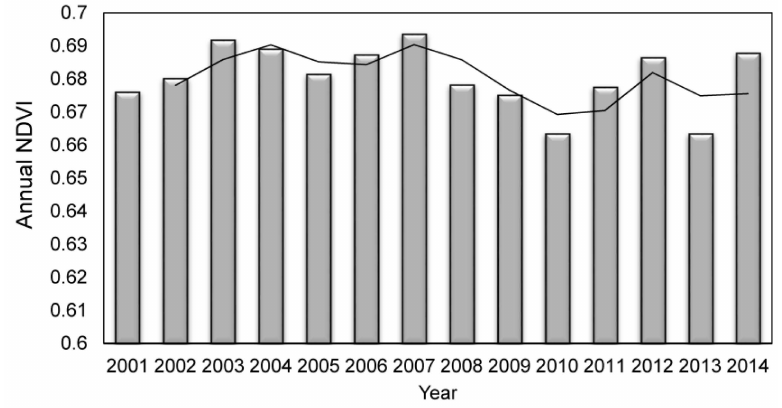
Figure 6. Average vegetation values per year and monthly boxplots of vegetation index (average national value) in El Salvador between 2001 and 2014. The line shows a running average for the average annual values across the study time period.